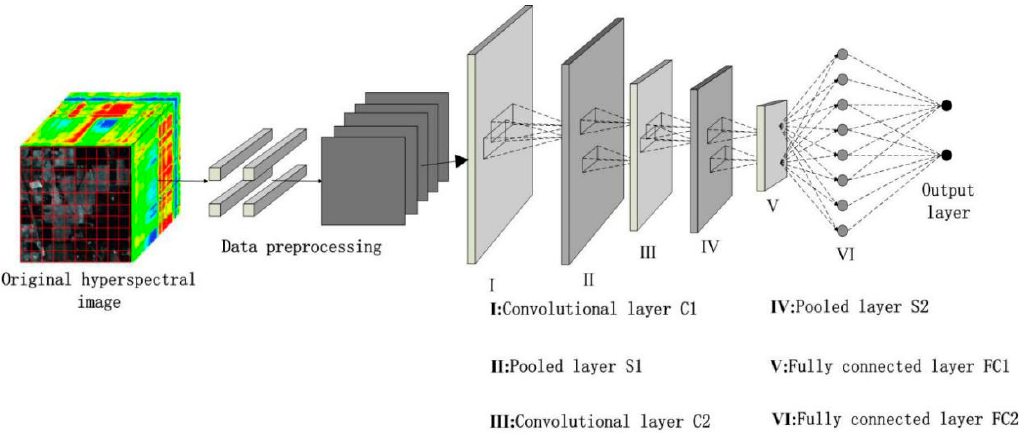
Figure 4. Image classification framework based on CNN.